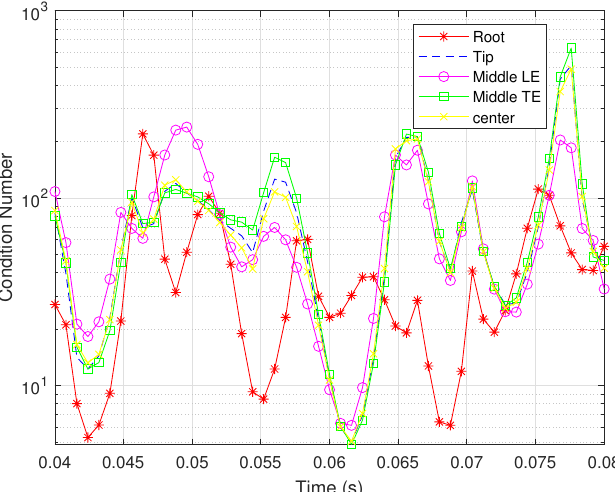
Figure 13. Condition numbers for shear strain sensors located in different places.